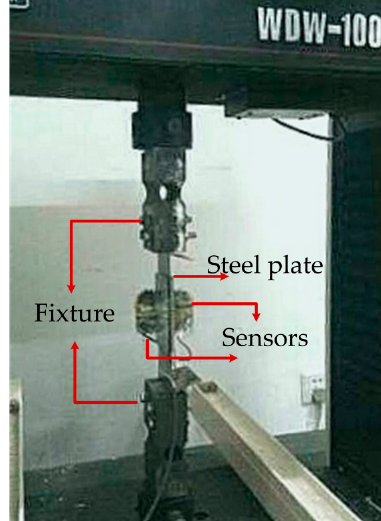
Figure 8. Photo of the magnetic stress detection system in working condition.